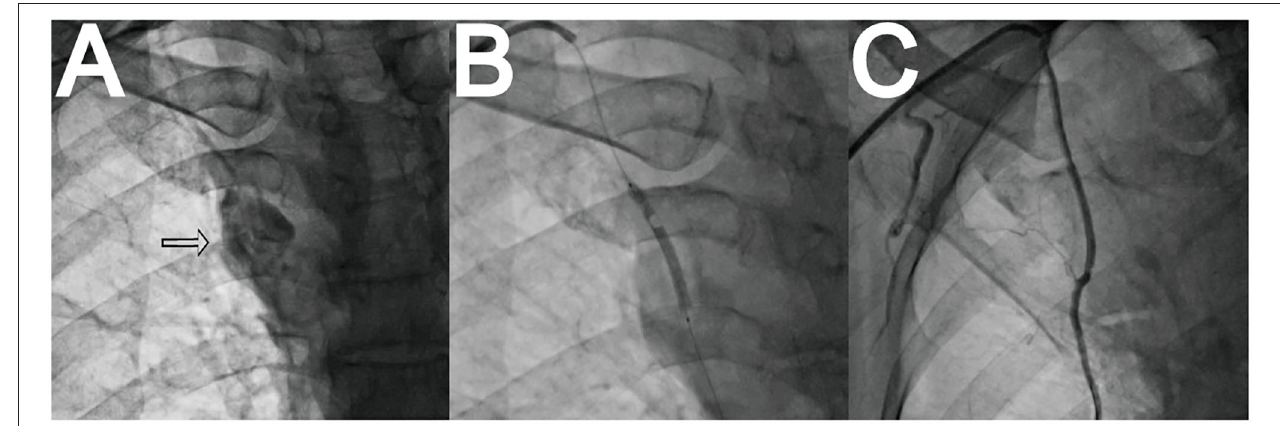
FIGURE 2 | Unexpected perforation of right internal mammarian artery (RIMA) and treatment. (A) RIMA perforation. (B) Covered stent implantation. (C) Perforation sealed.